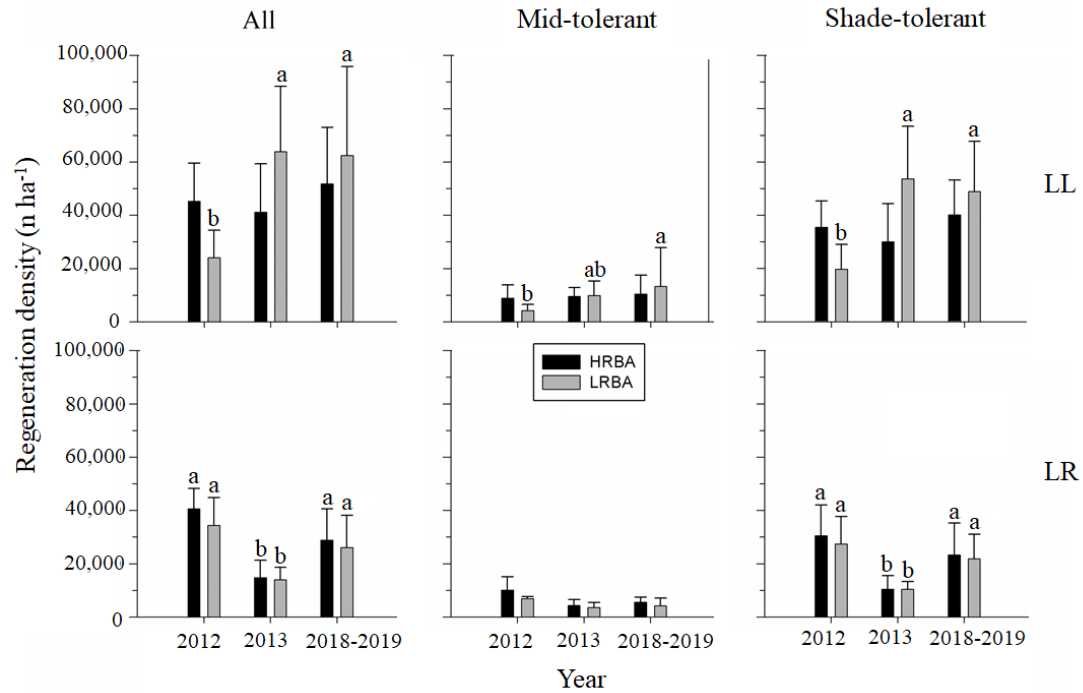
Figure 5. Mean (bars) and standard deviation (whiskers) in the density of all seedlings (n ha − 1 ) by functional group according to year, treatment, and site. The di ff erent letters between bars of the same color show significant di ff erences between the years (value of p < 0.05).